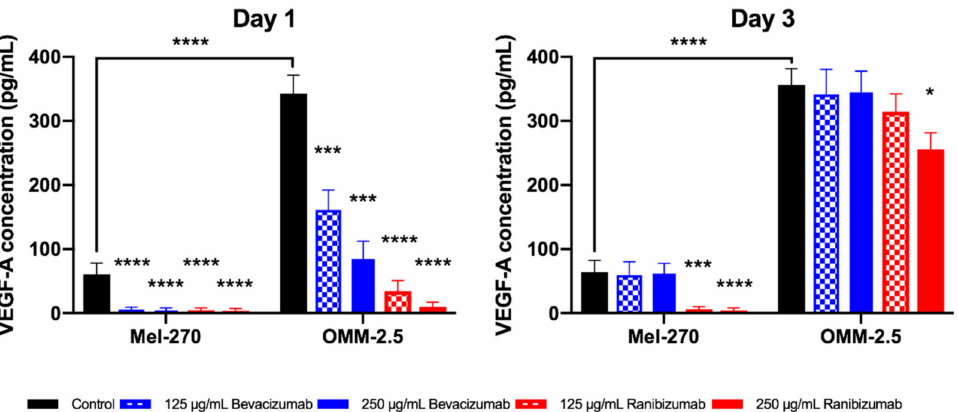
Figure 2. Extracellular vascular endothelial growth factor-A (VEGF-A) levels of Mel-270 und OMM-2.5 cells after a one-day exposure to bevacizumab or ranibizumab as determined by ELISA.